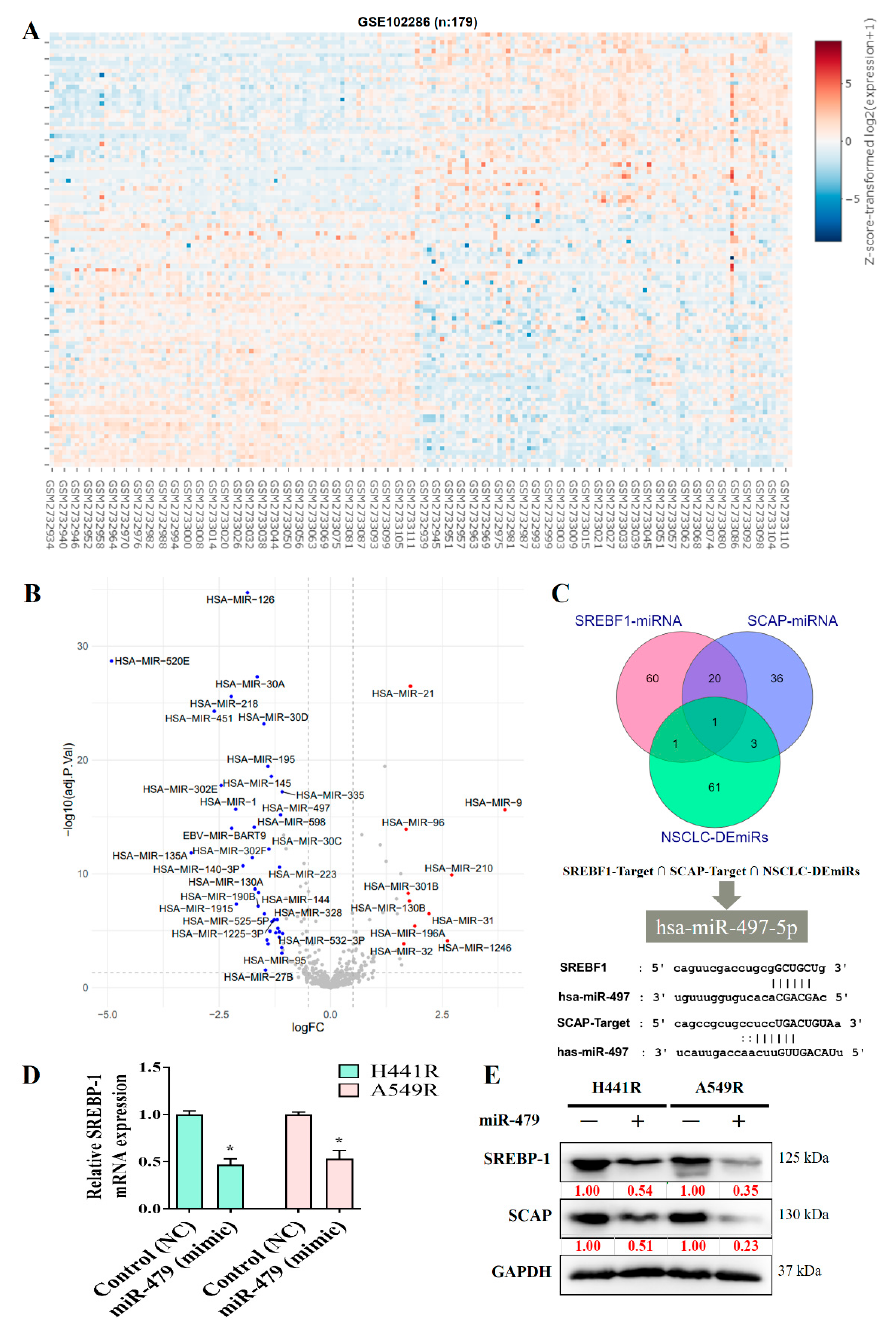
Figure 6. miRNA expression profiles of NSCLC cells. ( A ) Heat map and ( B ) volcano plot of miRNA expression profiles of NSCLC cells. Differentially expressed (DE) miRNAs were identified from the GEO (GSE102286) database containing 179 total lung patient samples using the criteria of |logFC| > 1 and p < 0.05. ( C ) Intersection analysis of predicted miRNAs targeting SREBP-1 and SCAP. Pre-